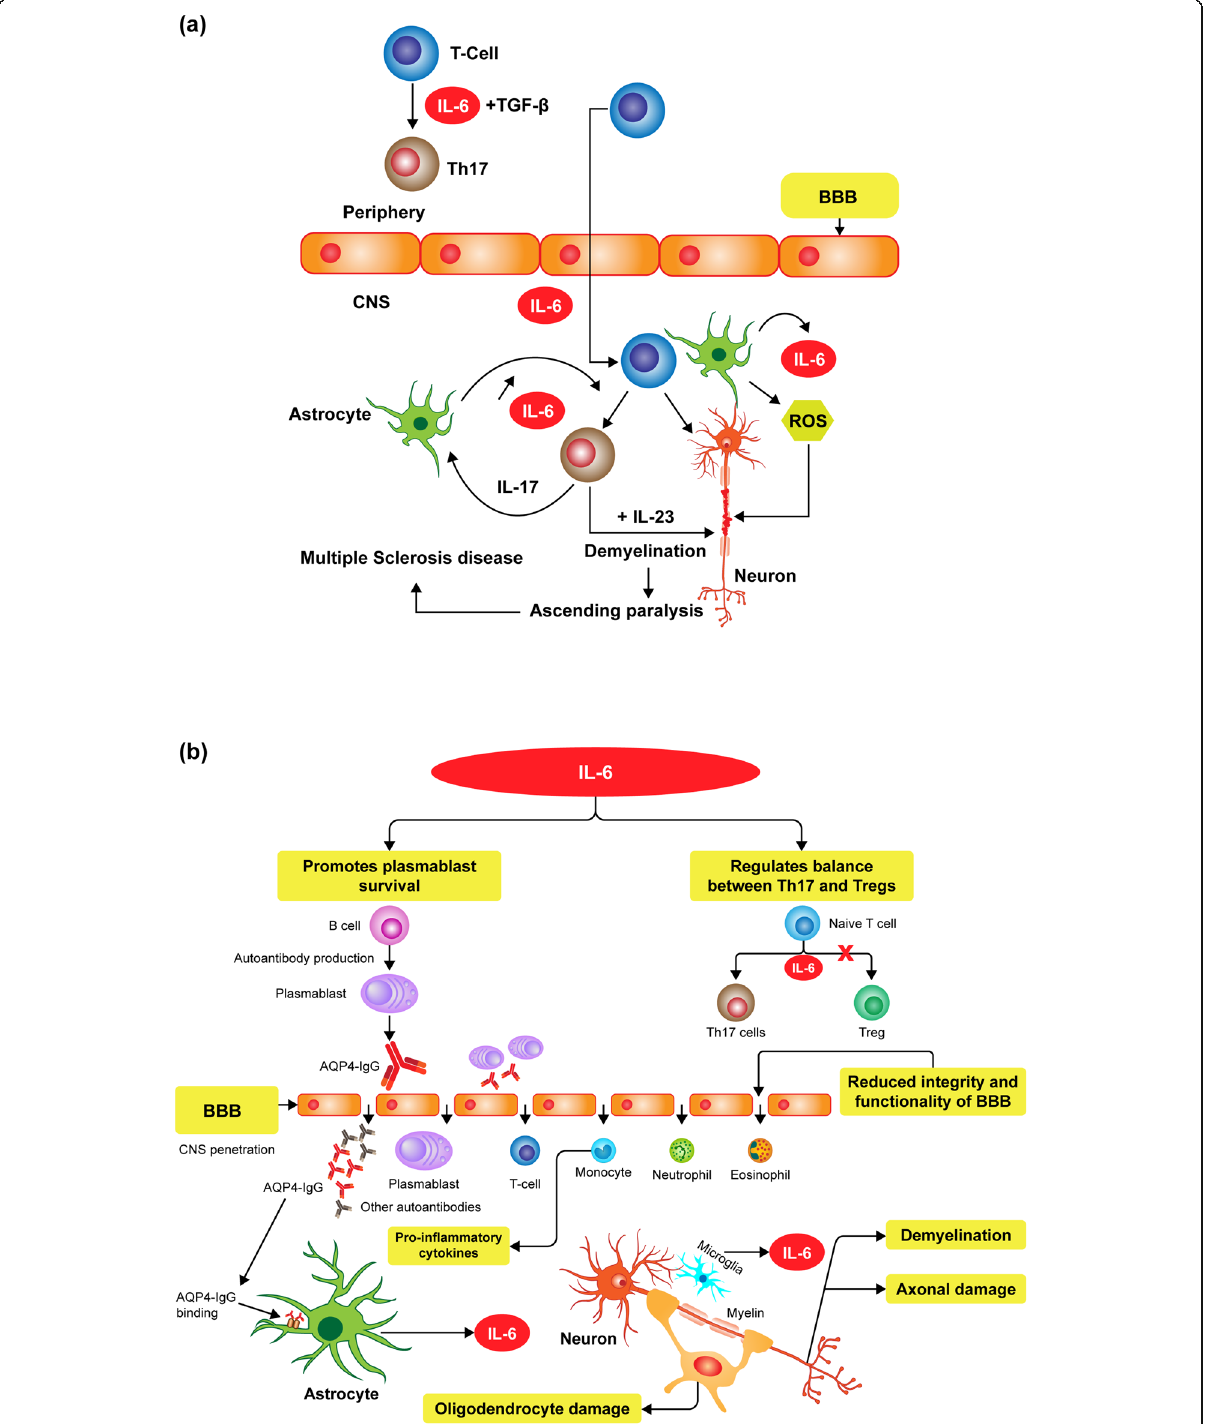
Fig. 2 A Role of IL-6 in the pathophysiology of multiple sclerosis. BBB, blood – brain barrier; CNS, central nervous system; IL, interleukin; ROS, reactive oxygen species; TGF- β , transforming growth factor beta; Th, T-helper. B Role of IL-6 in the pathophysiology of NMOSD. AQP4, aquaporin- 4; BBB, blood – brain barrier; CNS, central nervous system; IgG, immunoglobulin G; IL-6, interleukin 6; NMOSD, neuromyelitis optica spectrum disorder; Th, T helper; Treg, regulatory T